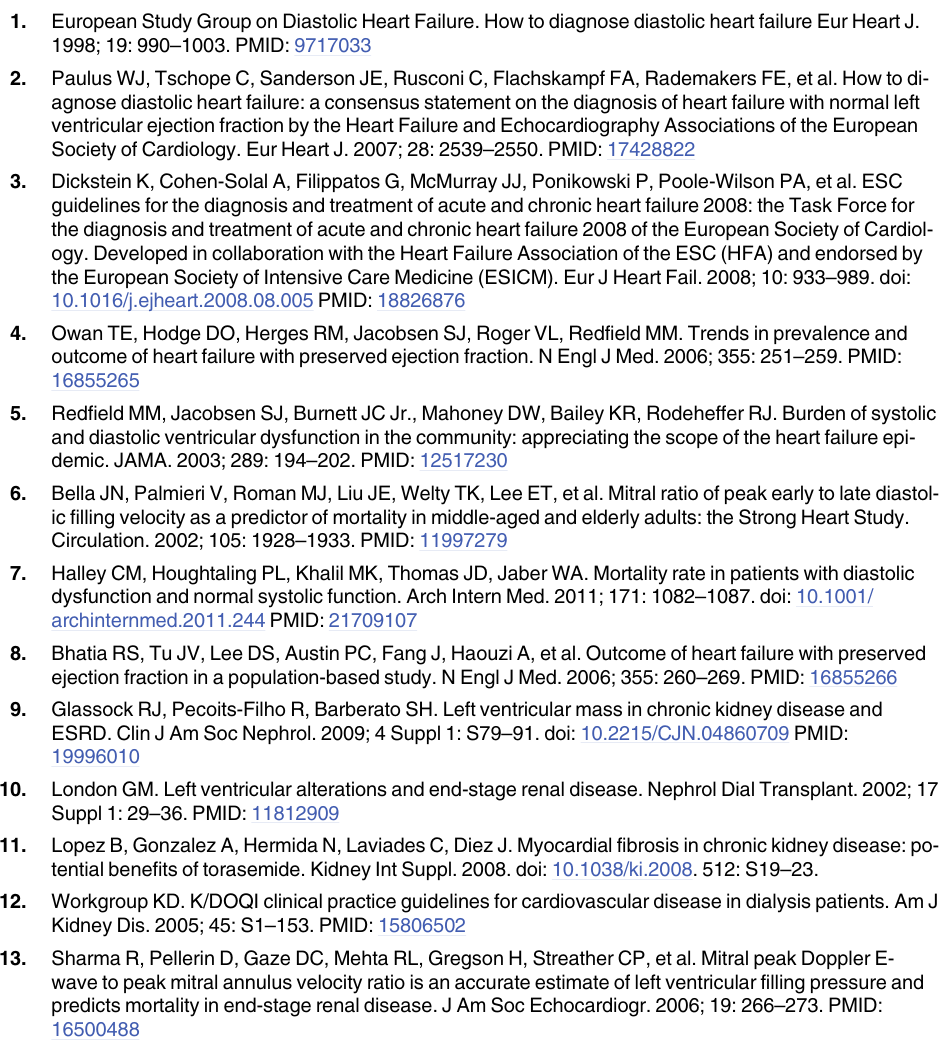
S1 Fig. Flow diagram of patient selection and outcomes. From July 2008 to August 2012, 293 patients who started HD or PD at Yonsei University Health System were initially recruited for enrollment, and 194 patients were included in the final analysis after excluding 24 patients who did not undergo echocardiography and 75 patients who met the exclusion criteria. Patients were divided into two groups according to the presence of CV events; CV event-free group and CV event